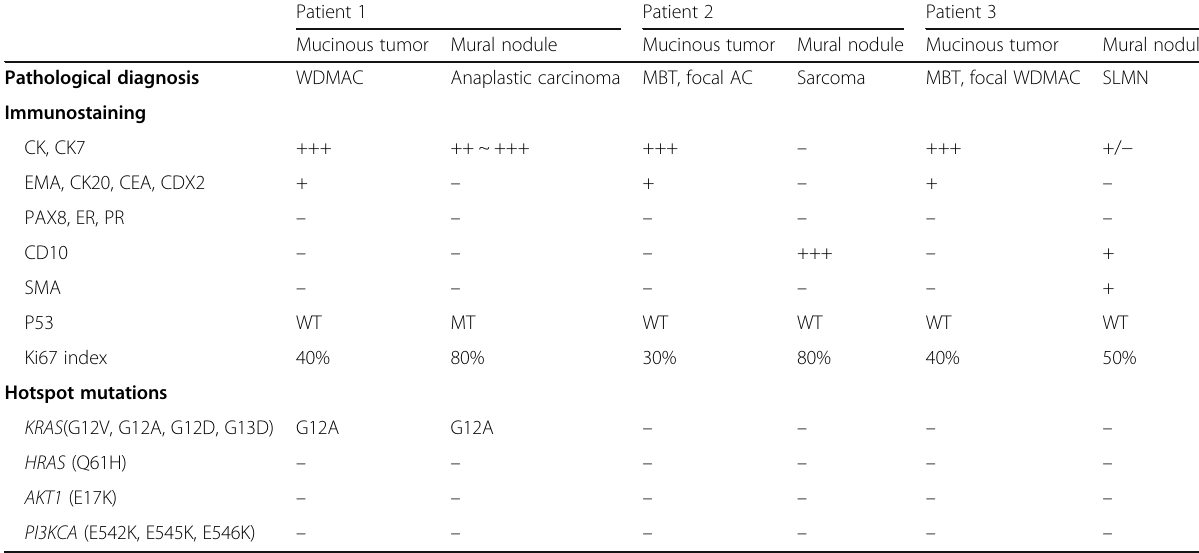
Table 2 Immunohistochemical and molecular findings of ovarian mucinous tumors with mural